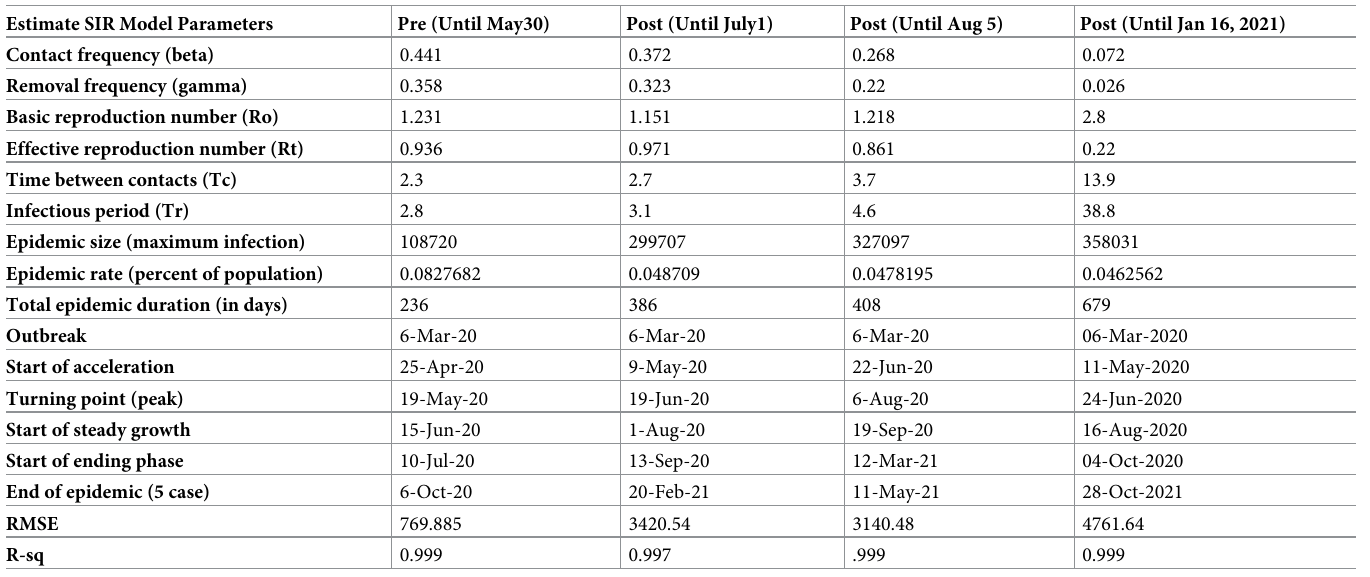
Table 1. SIR model predicting COVID-19 epidemic in KSA in lockdown and post-lockdown scenarios. Estimate SIR Model